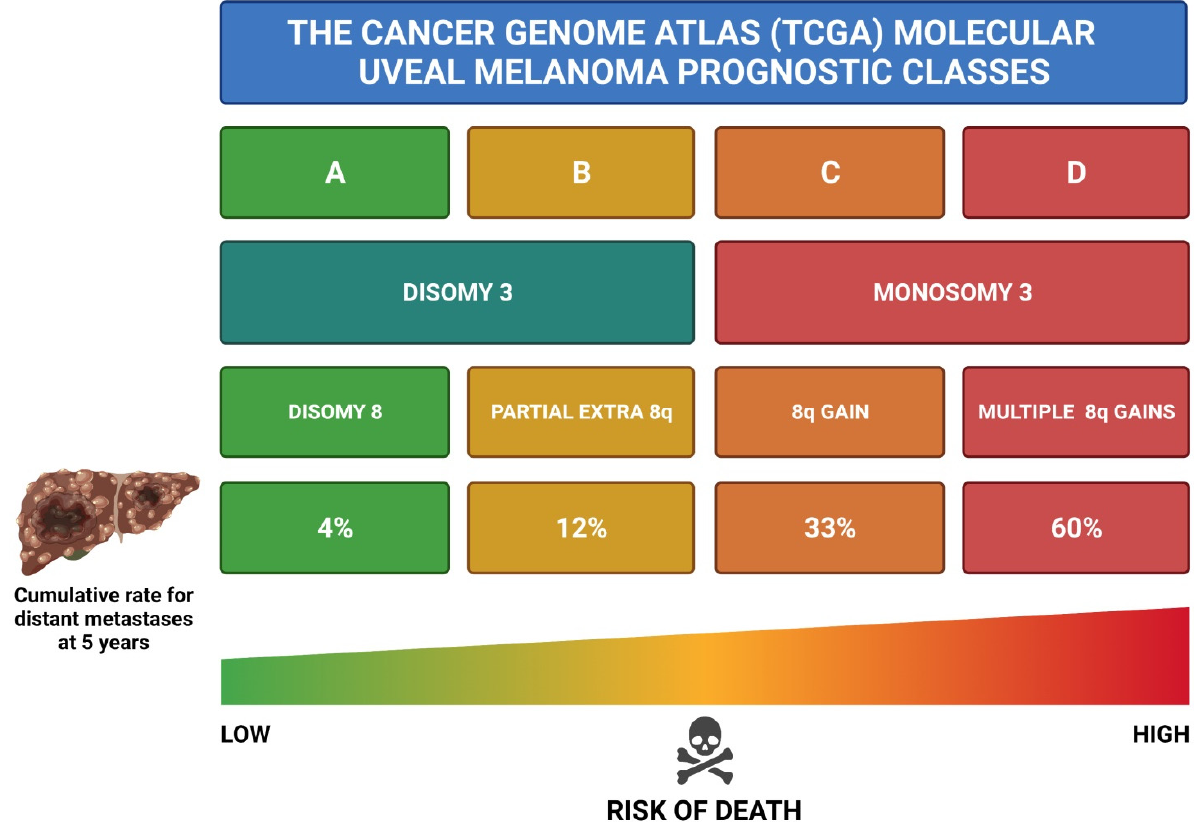
Figure 3. New molecular prognostic classification for uveal melanoma based on the data generated by the TCGA project involving primary uveal melanoma cases [40]. The new model comprises four main prognostic classes: class A [D3/D8], class B (D3/partial extra 8q), class C (M3/8q gain) and class D (M3/multiple 8q gains). The risk of metastases development increases progressively from class A to class D. Uveal melanoma patients in class D have the least favourable prognosis, with nearly all patients dying within the first decade after diagnosis. Diagram generated in line with previous literature [3,36,39,40,73] (Diagram created with BioRender.com, accessed on 15 December 2021).